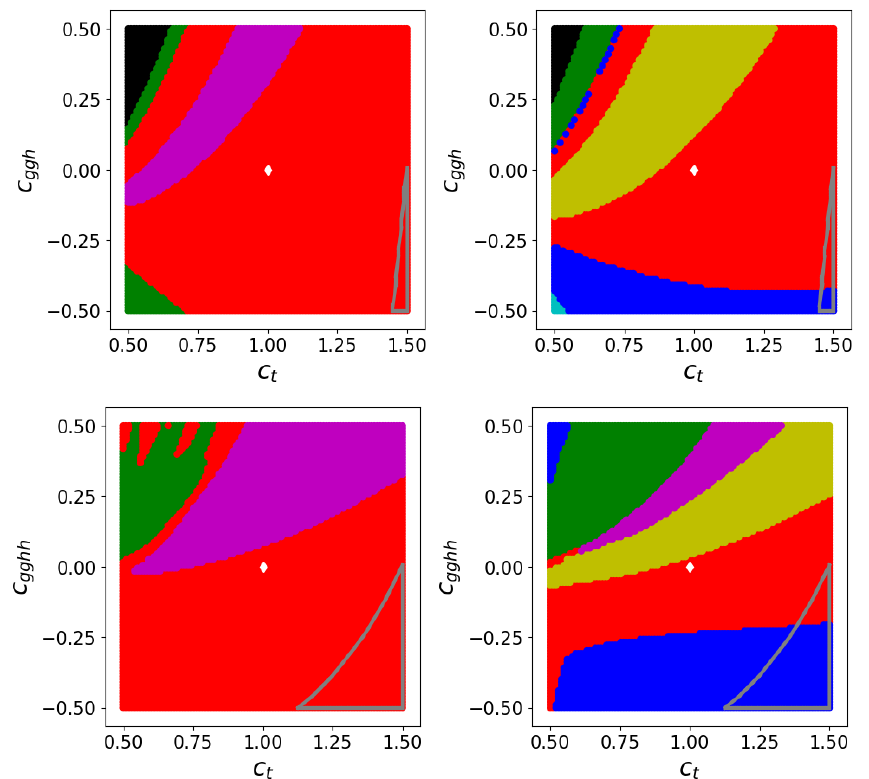
Figure 16 . Shape types produced by variations of c t versus c ggh (top) and c gghh (bottom). Left: 4 clusters, right: 7 clusters. The areas outside the silver and white curves are regions where the total cross section exceeds 6 : 9 (cid:2) (cid:27) SM and 22 : 2 (cid:2) (cid:27) SM , respectively. These values are motivated by p the current ATLAS/CMS limits at s = 13 TeV [1, 2]. The red areas denote SM-like shapes.